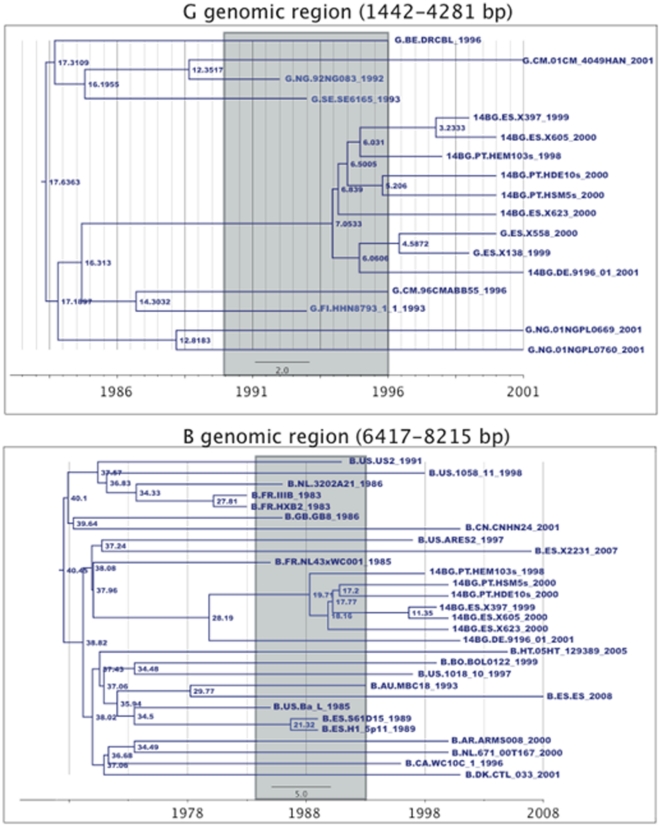
Maximum Clade Credibility Tree for the subtype G and subtype B genomic regions of the CRF14_BG.The 95% confidence interval for the date of origin of CRF14_BG is indicated in both trees as a grey square. Node values indicate its time of origin. Sequence names are coded as [Subtype].[Country].[Seqname]_[Year of Sampling].